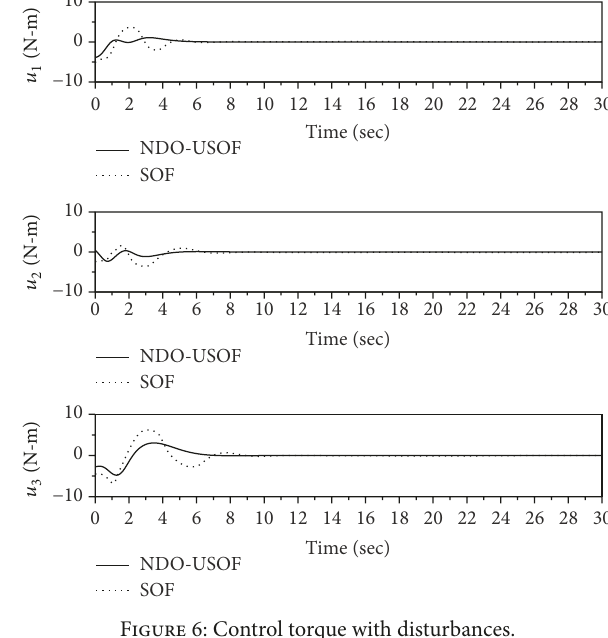
Figure 6: Control torque with disturbances.